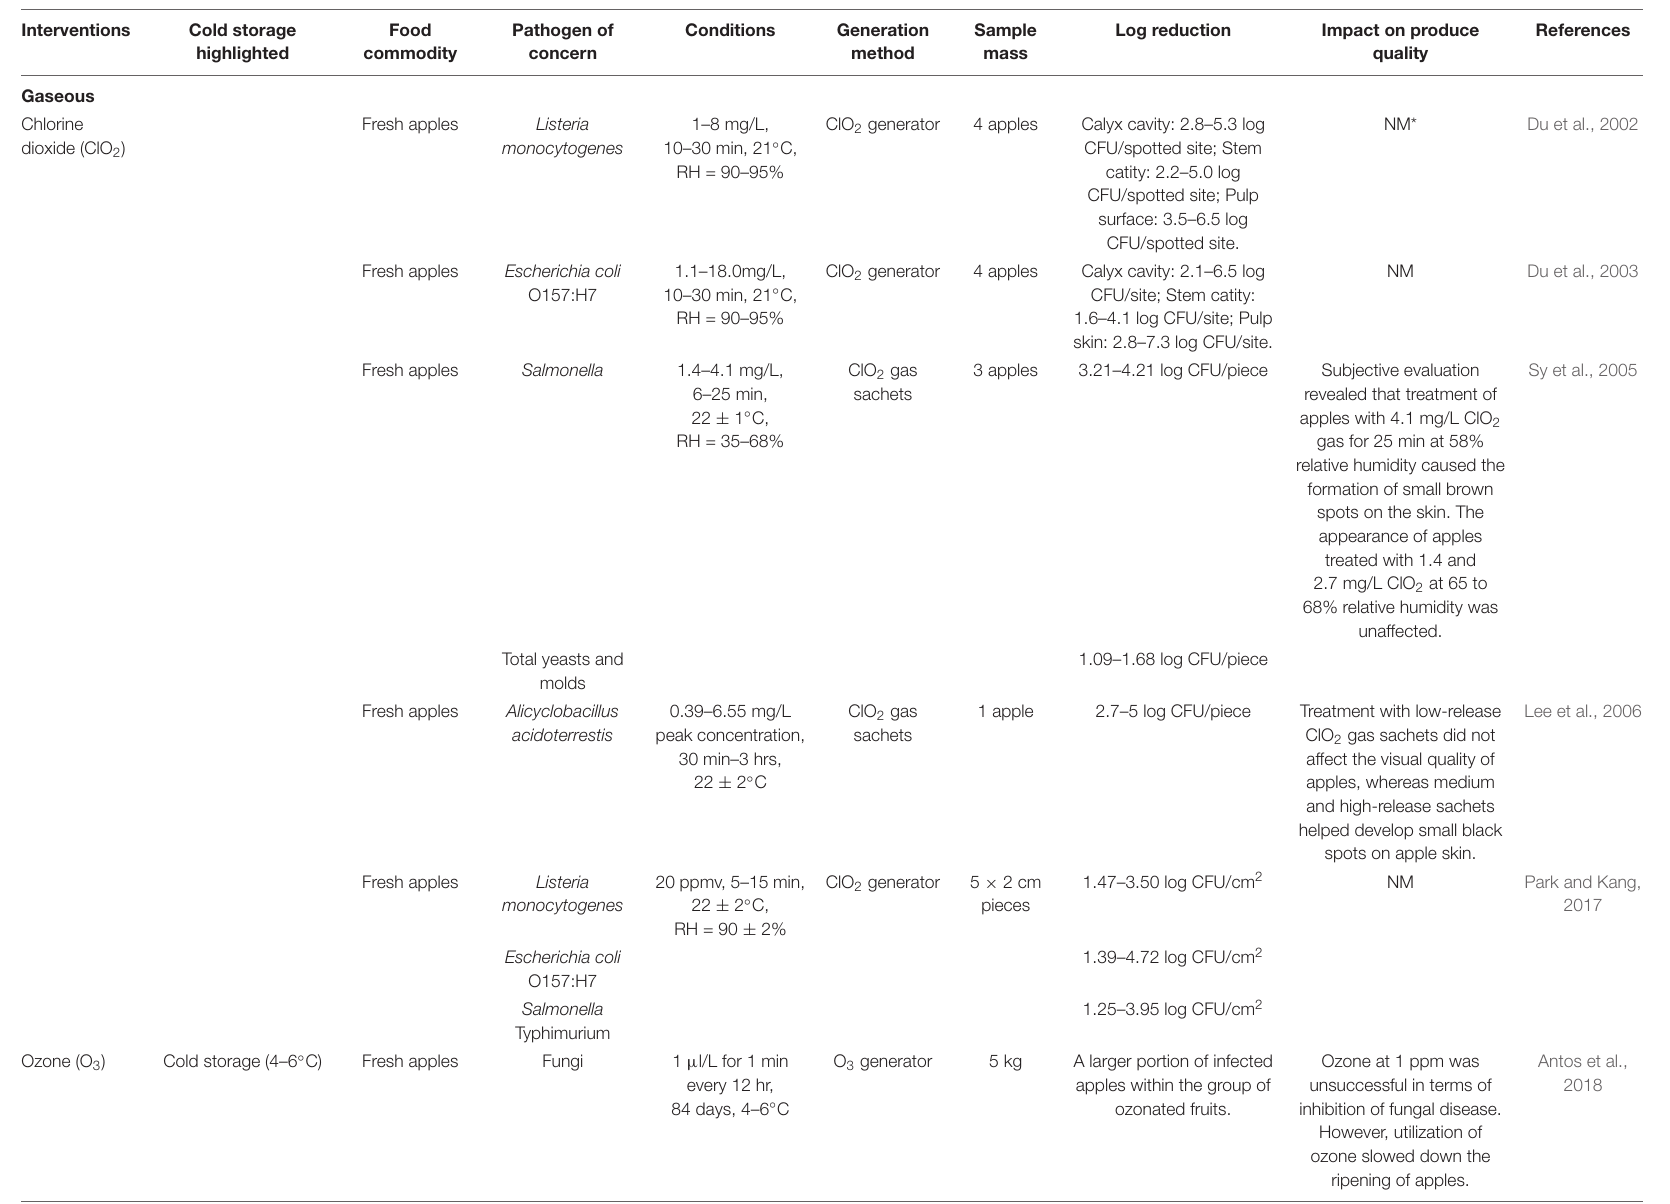
TABLE 1 | Gaseous food safety interventions for bacteria decontamination on fresh apples.